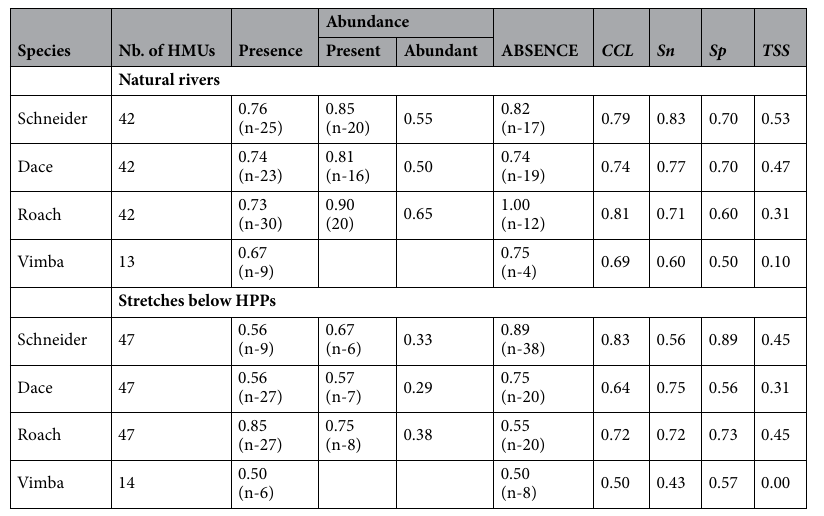
Table 3. Proportion of correctly predicted presence, abundance and absence, as well as overall proportion of correctly classified instances ( CCL ), sensitivity ( Sn ), specificity ( Sp ) and true skill statistic ( TSS ) of CHSC in natural rivers and river stretches below HPPs. Numbers in brackets denote the number of HMUs in which species had to be present, abundant or absent based on